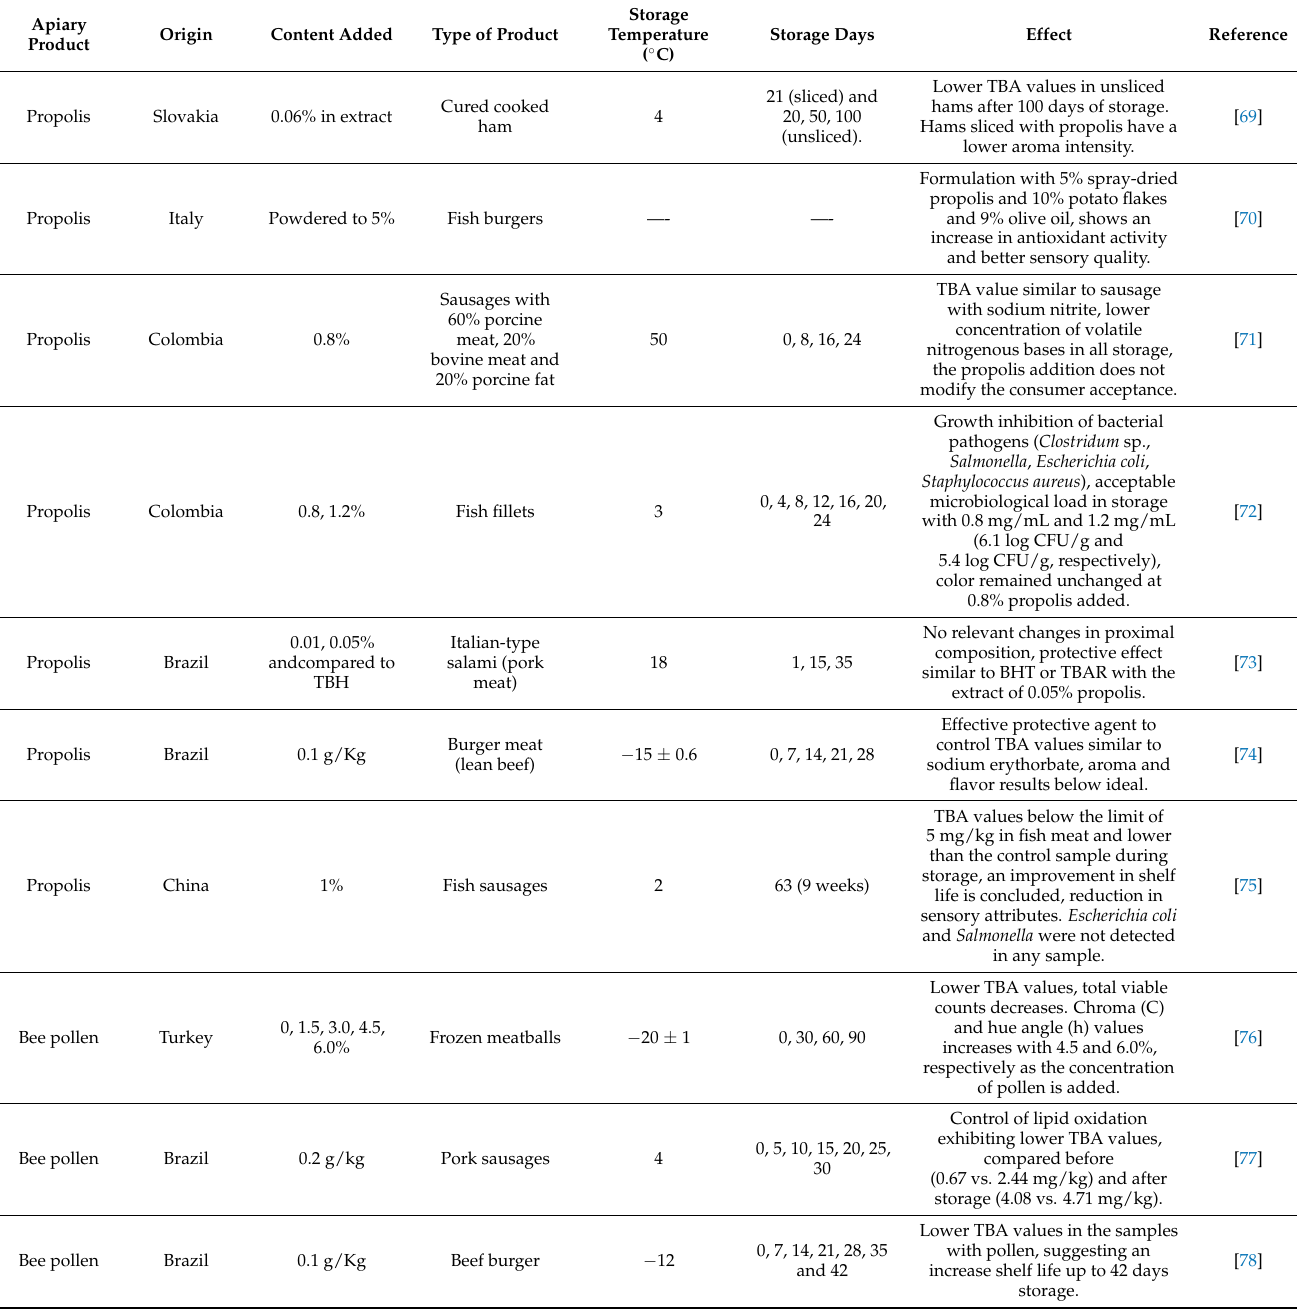
Table 2. Effect of the addition of bee products as natural antioxidants in storage conditions, on lipid oxidation, composition, microbiological, and sensory quality in meat